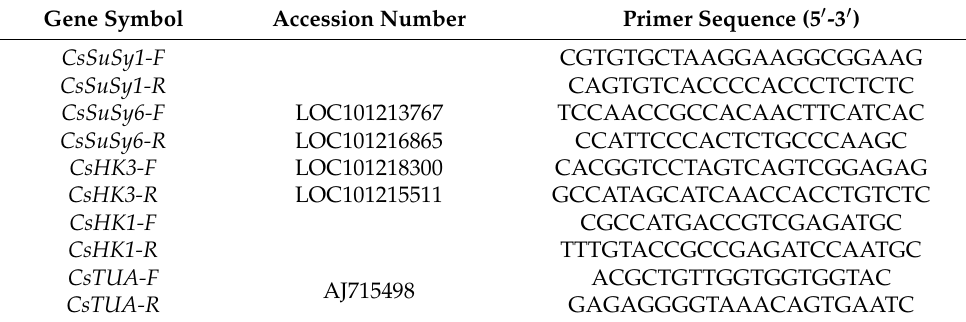
Table 1. Sequences of primers used for qRT-PCR